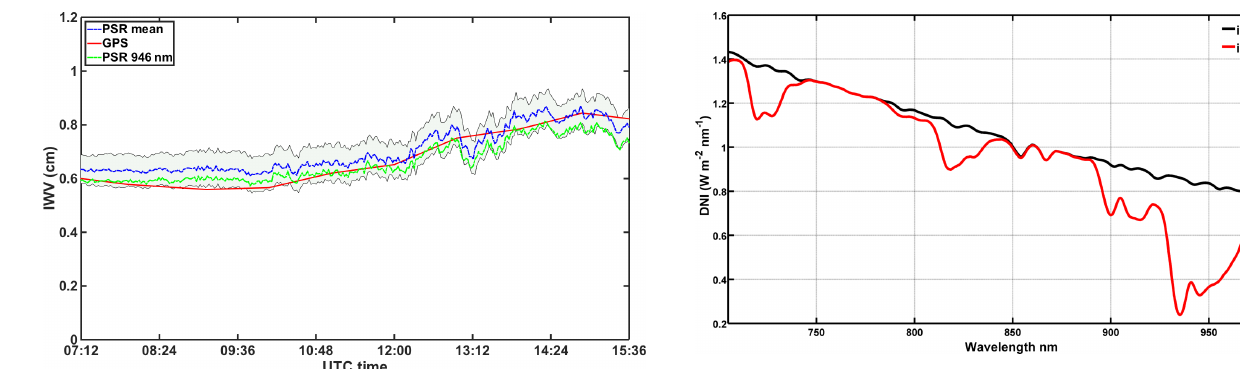
Figure 4. Retrievals of monochromatic approach on 30 Septem- ber 2015 at various wavelengths. Average IWV retrieved using the monochromatic approach at different wavelengths represented by blue line; the shaded area represents the standard deviation (1 σ ) of retrievals at different wavelengths, the green line represent retrievals at suggested 946nm and the red curve represents the IWV retrieved from GPS.